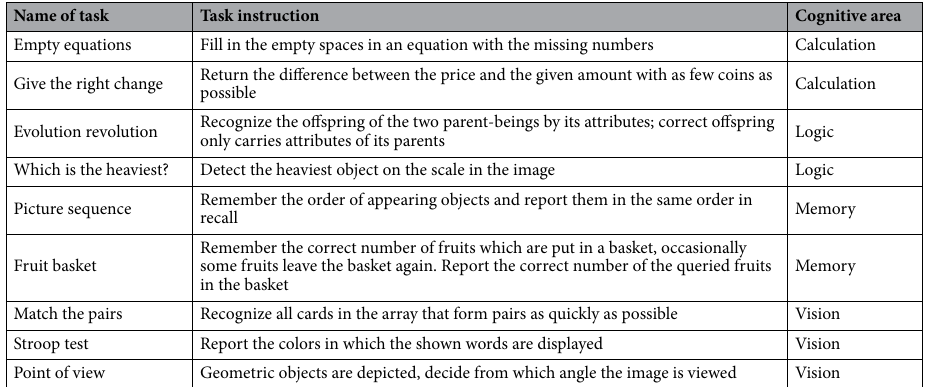
Table 4. Overview of the tasks of MyBrainTraining. The tasks and their order were held constant over all participants for all three time points. The selection of the 9 tasks was based on the goal to assess cognitive performance across all areas of MBTs task categories, namely calculation, logic, memory and vision. In the column task instruction, the task’s demands are briefly described. In the column cognitive area, the allocation of the tasks to MBTs task categories is reported. Depending on the participant’s choice, the cognitive tasks were executed either in the web-browser or via the app on her*his smartphone. Participants were instructed to complete the tasks in a distraction-free environment and to focus on the